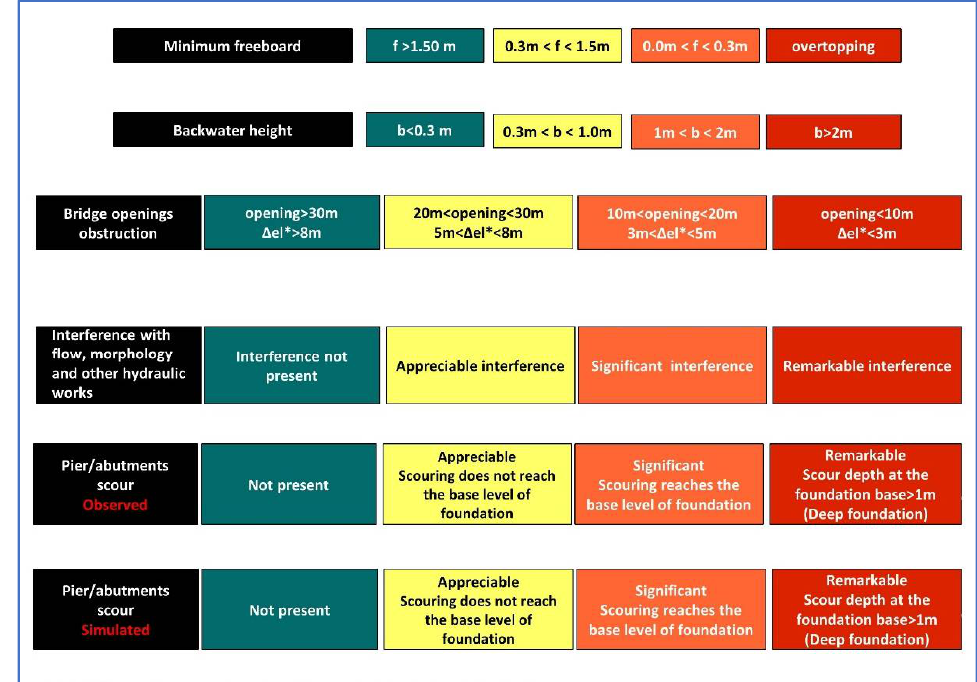
Figure 2. Threshold parameter values for different vulnerability levels.